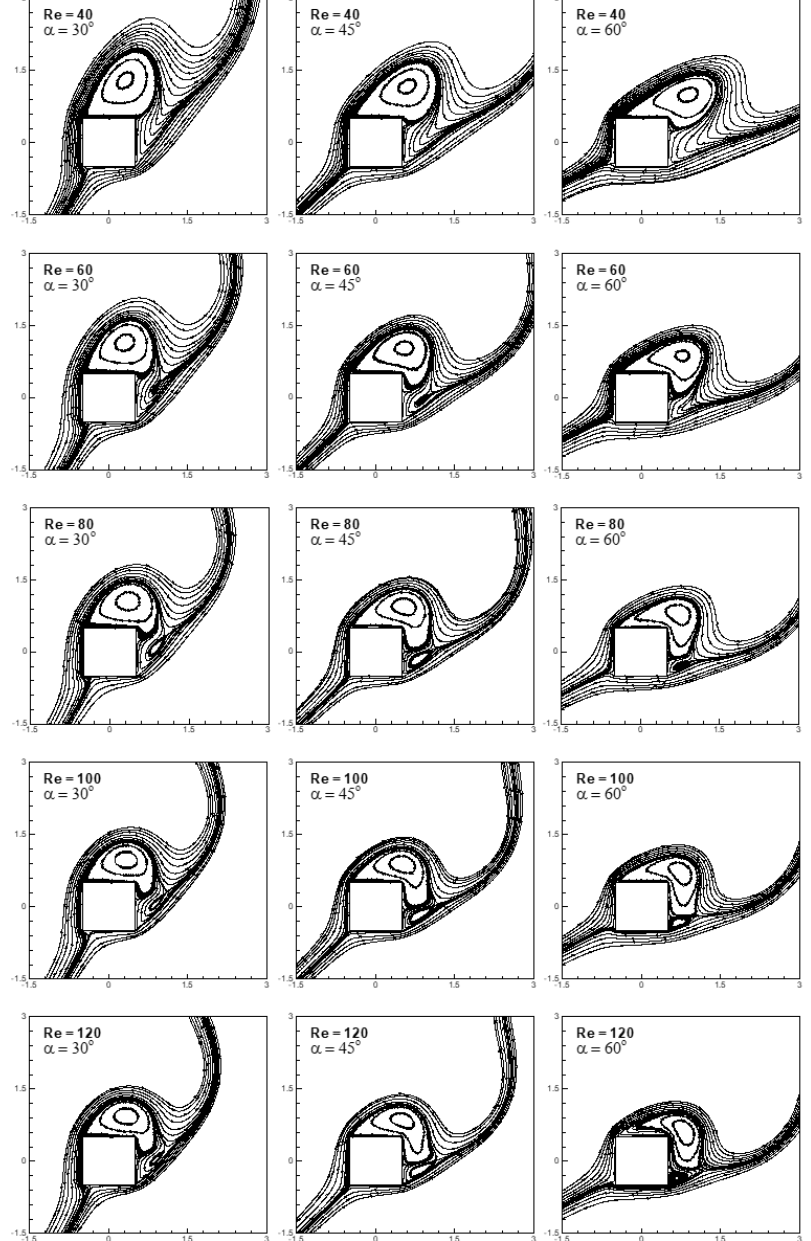
Figure 5. Instantaneous streamline patterns in the vicinity of the square cylinder for 40 ≤ Re ≤ 120, 30° ≤ α ≤ 60° at Ri = 0.